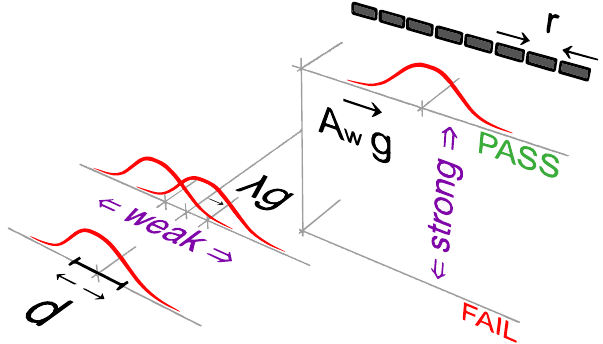
FIG. 1 The AAV setup. A particle ’ s spatial wave function is weakly coupled to an internal observable A , causing it to undergo a small lateral shift conditional on the internal state. It is then strongly postselected into the eigenstate of another observable B and allowed to impinge on a array of pixels with width r . By tuning certain parameters, one can induce larger-than-usual average displacements at the detection stage. This figure illus- trates the dim ð H Þ ¼ 2